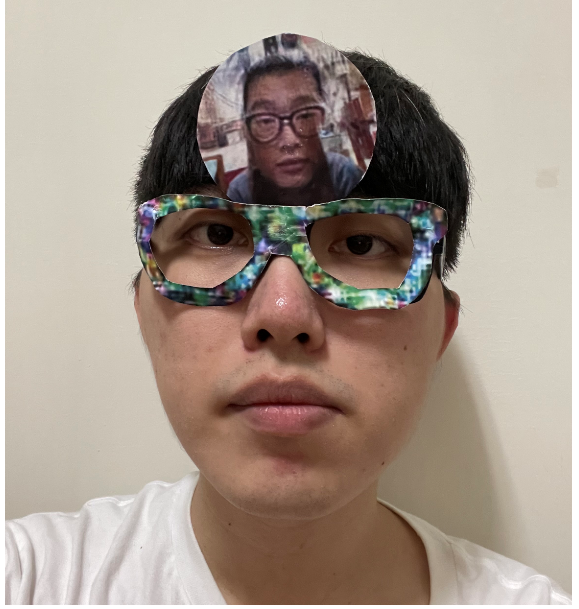
Figure 9. Wearing of adversarial glasses and an adversarial face in the physical world.